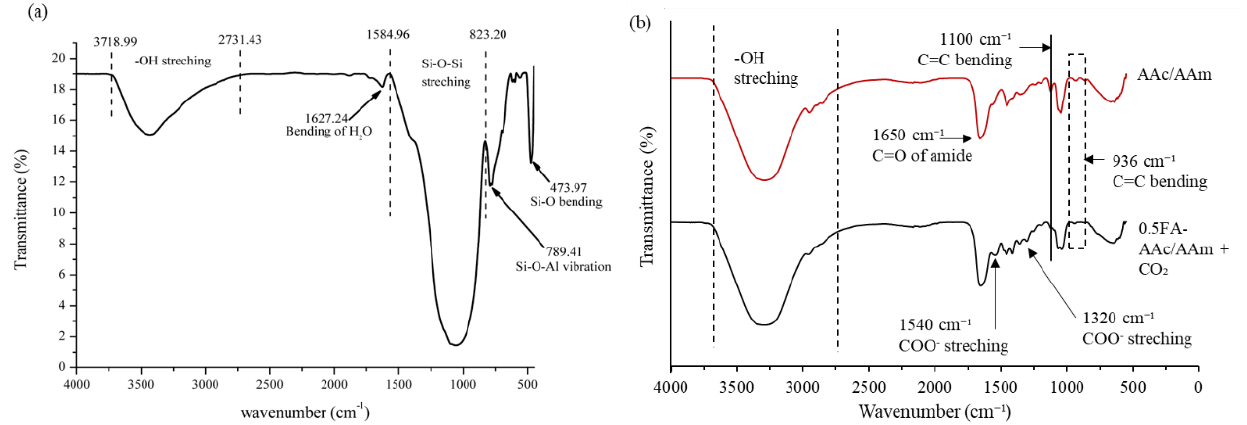
Figure 2. The FTIR spectra ( a ) FA and ( b ) the AAc/AAm hydrogel and 0.5FA-AAc/AAm+CO 2 (hydrogel after CO 2 capture).